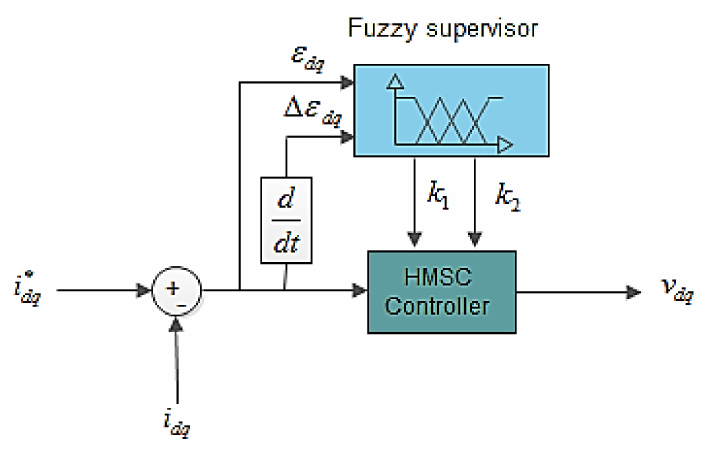
Figure 2. Proposed strategy design.